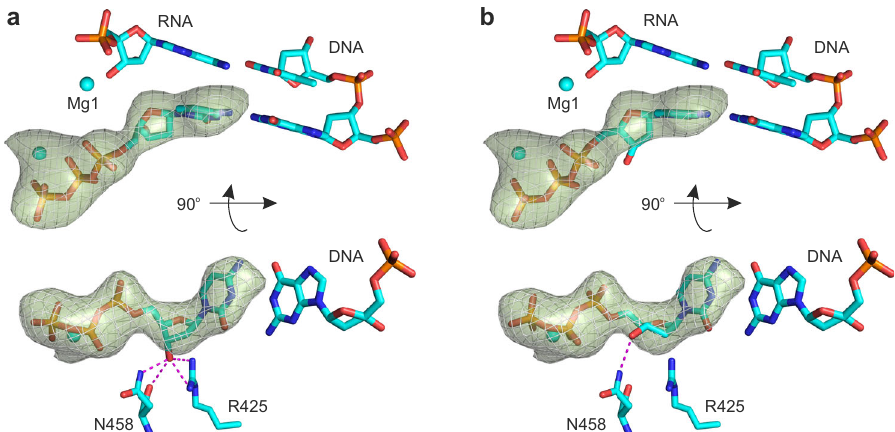
Fig. 6 The 2 ′ - and 3 ′ -endo 2 ′ dCTPs fi tted into the omit map (3 σ ) of the RNAP-2 ′ dCTP complex. a The 3 ′ OH group of the 2 ′ -endo conformer is positioned to form up to three hydrogen bonds and a polar interaction with RNAP atoms (magenta lines, interatomic distances 2.5 – 3.1 Å). b The 3 ′ OH of the 3 ′ -endo conformer can hydrogen bond with one RNAP atom. The 2 ′ - and 3 ′ -endo conformers were derived from PDB IDs 2HVW (resolution: 1.67 Å) and 4DQI (resolution: 1.69 Å), respectively, and fi tted into the omit map by rotating bonds but preserving bond lengths and angles. Source data are provided as a Source Data fi le.